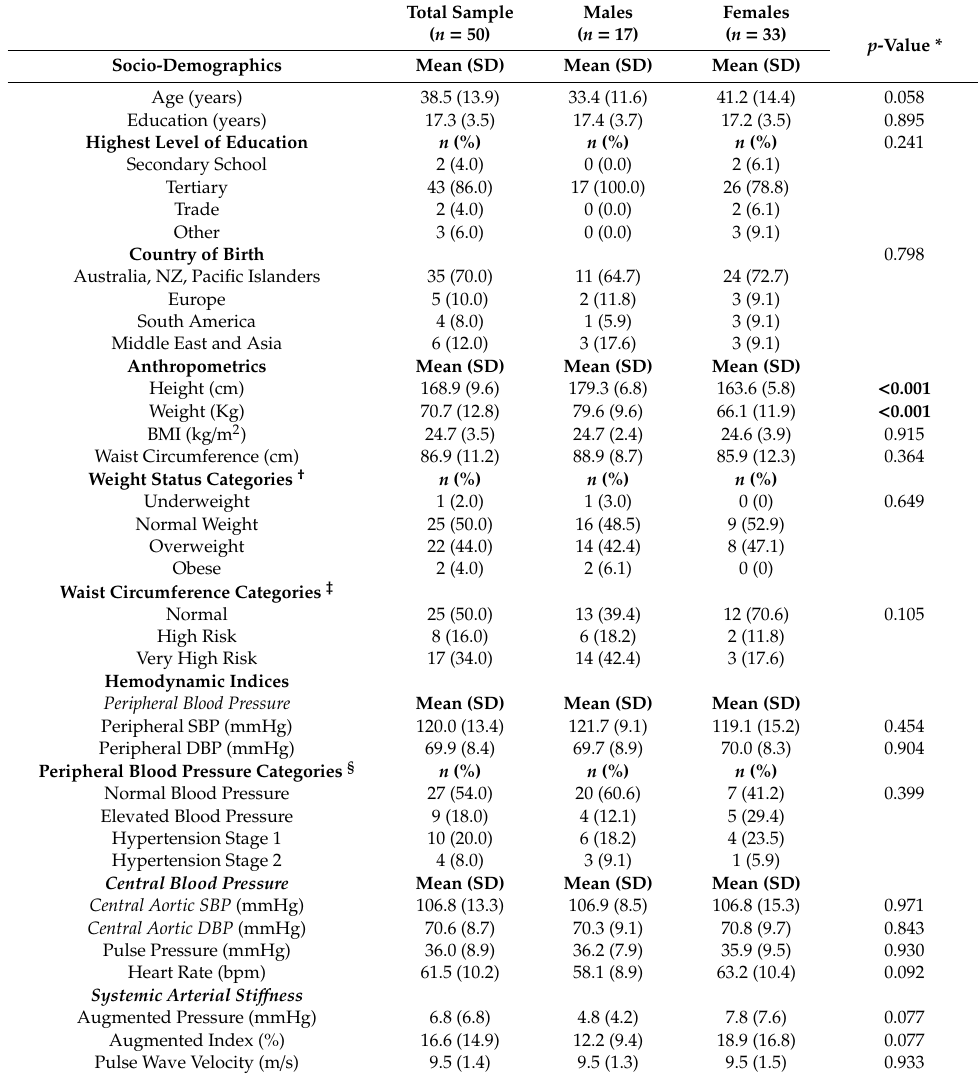
Table 1. Descriptive characteristics of study